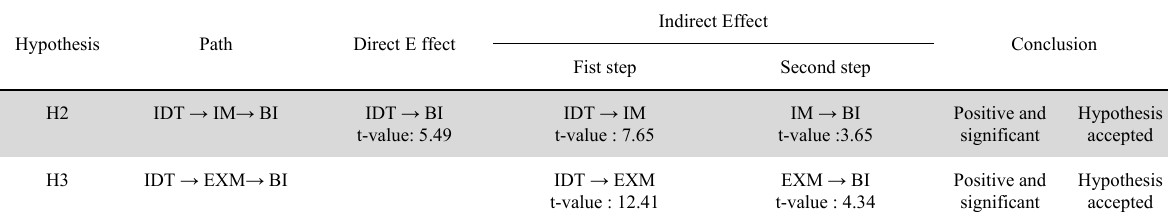
Results of Indirect Effect Hypothesis